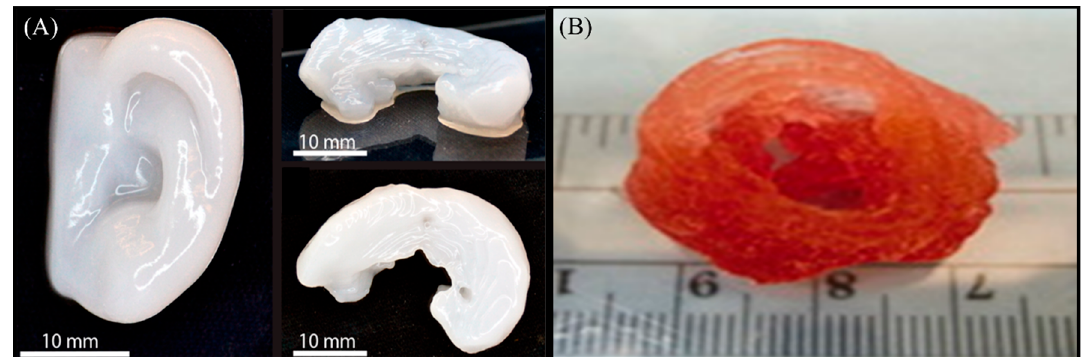
Figure 2. Examples of 3D-bioprinted tissue: ( A ) 3D-printed human ear and sheep menisci [66] (reprinted with permission from American Chemical Society Publications); ( B ) as-printed aortic valve conduit [62] (reprinted with permission from Wiley). Table 5. Tissue-engineering applications using 3D bioprinting, adapted from Seol et al. [8] 144 (with permission from Oxford University Press). BMP-2—; FGF-2—; TGF- β —; CNTF—; 145 VEGF—; EGF—; GelMA—gelatin methacryloyl. 146